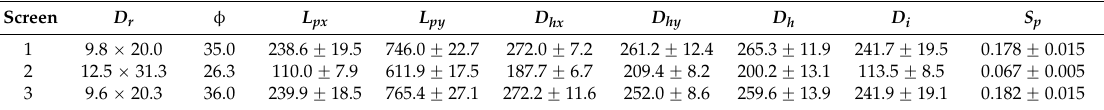
Table 2. Geometric characteristics of the insect-proof screens (Average value ˘ standard deviation): D r , thread density (threads ¨ cm ´ 2 ); φ , porosity (%); L px , weft pore length ( µ m); L py , warp pore length ( µ m); D hx , weft thread diameter ( µ m); D hy , warp thread diameter ( µ m); D h , mean thread diameter ( µ m); D i , diameter of the circumference drawn inside the pore ( µ m); S p , mean pore area (mm 2 ).